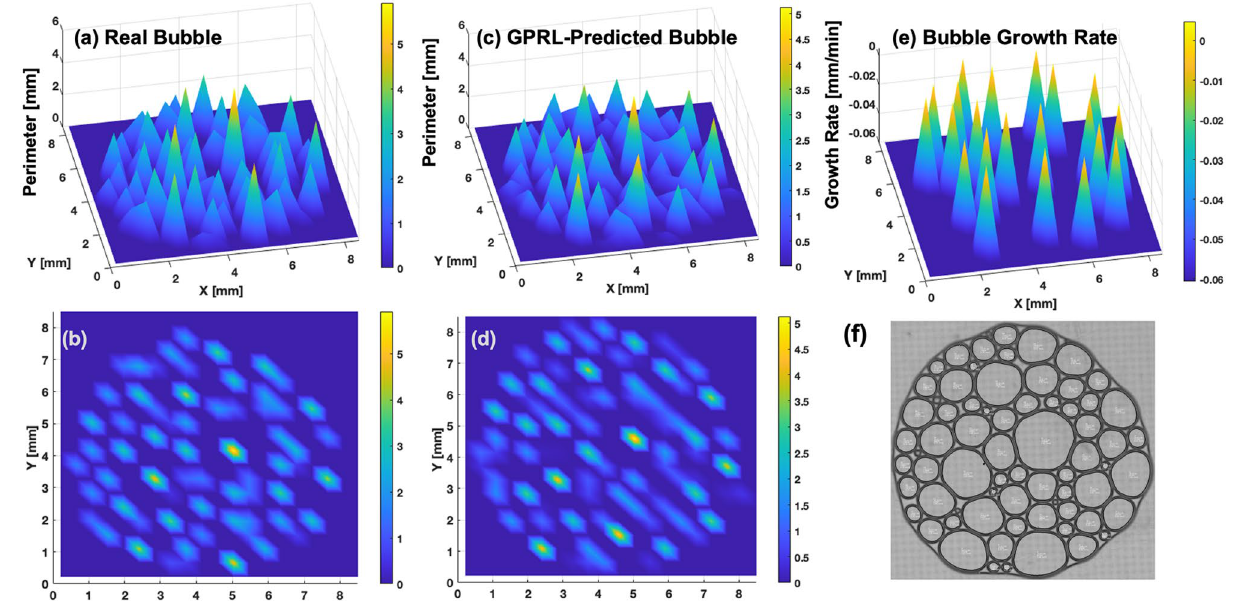
Figure 4. Independent prediction test with the best-so-far long-term prediction rules from GPRL. The GPRL- identified rule is applied to the independent “circular” shape bubble array: ( a ) and ( b ) are real bubble arrays from bird’s-eye view and plan view, respectively; ( c ) and ( d ) are simulated bubble arrays (MAE = 0.0506); ( e ) Best-so-far bubble growth rate; ( f ) Snapshot of the real bubble array of the elongated specimen at the target time step 72 (i.e., t = 36 min). Prediction gap = 30 min. The GPRL prediction requires four observed snapshots at t = 0, 2, 4, and 6 min to predict bubble at t = 36